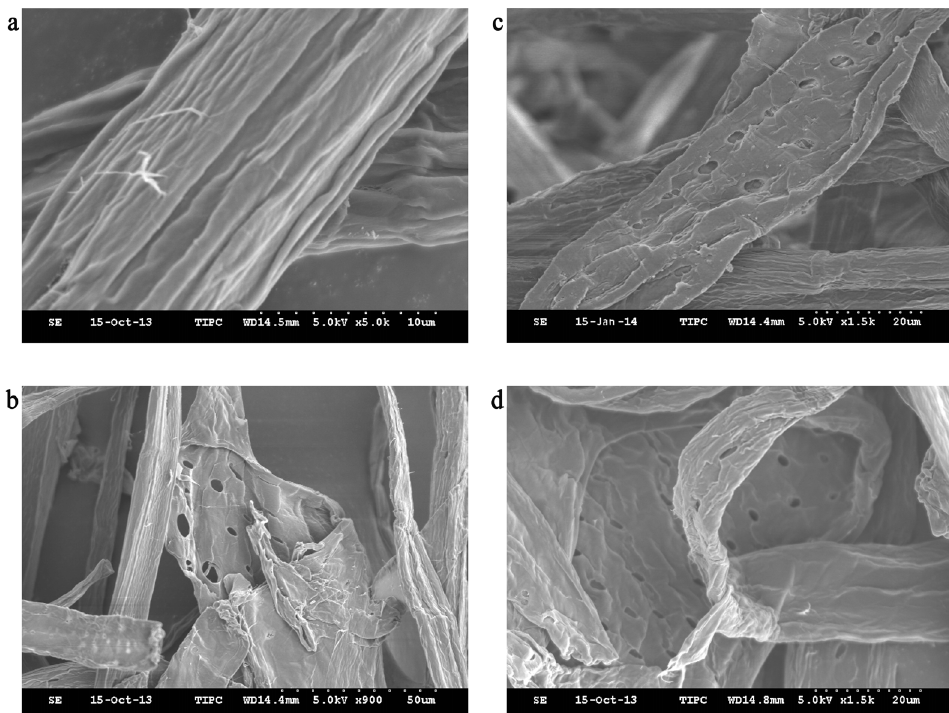
Figure 6. Morphology of bleached pulp fiber surface. Scanning electron micrograph of unbleached (control) eucalyptus kraft pulp ( a ). Scanning electron micrograph of MnP treated eucalyptus kraft pulp ( b ). Scanning electron micrograph of Svi DyP treated eucalyptus kraft pulp ( c , d ).